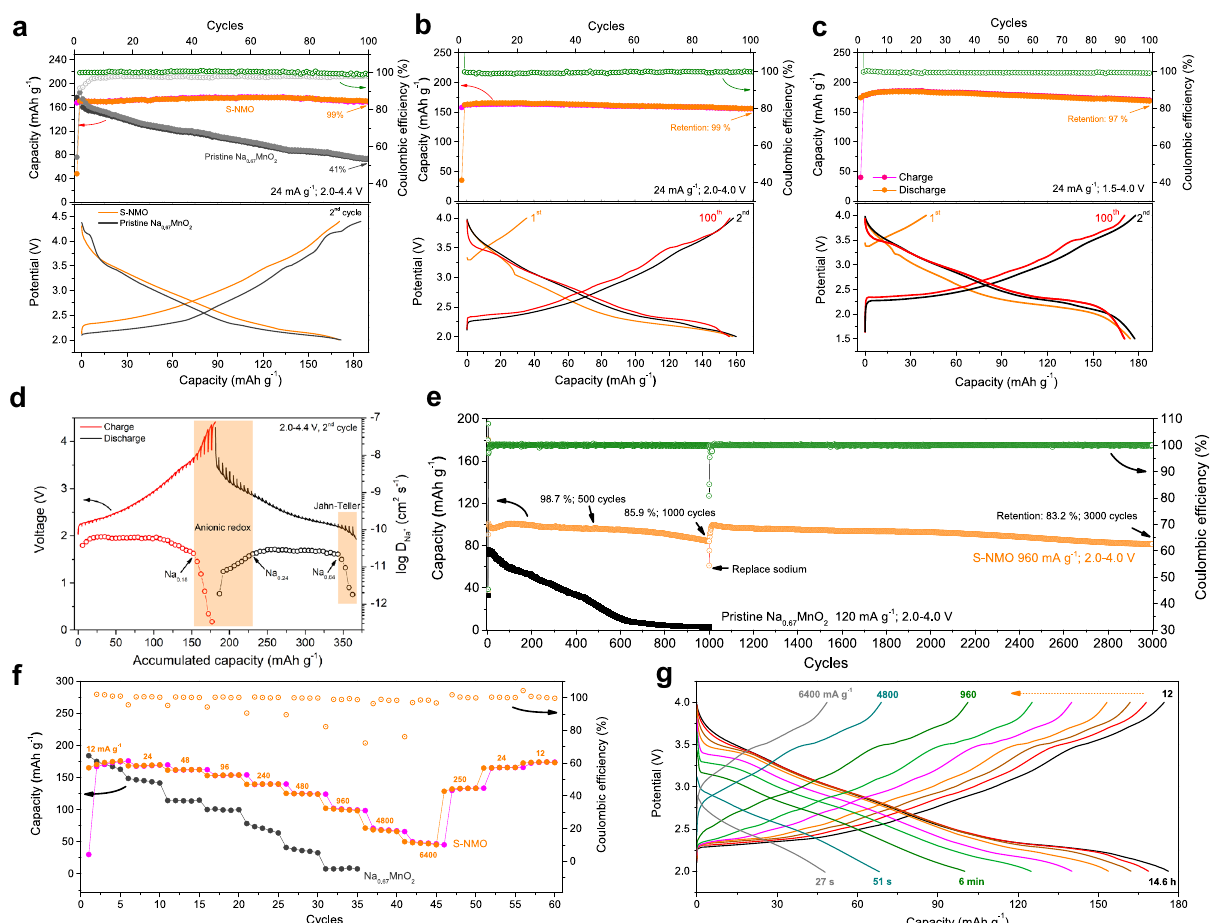
Fig. 5 Electrochemical performances of S-NMO. The cycling performances and charge – discharge curves of S-NMO electrode at 24mA g − 1 within the voltage ranges of a 2.0 – 4.4 V, b 2.0 – 4.0 V, and c 1.5 – 4.0 V. d GITT results of S-NMO electrode. e The comparison of the cycling performance of pristine Na 0.67 MnO 2 and S-NMO electrodes at 120 and 960 mA g − 1 , respectively. f The rate performance of pristine Na 0.67 MnO 2 and S-NMO at the voltage range of 2.0 – 4.0 V. g The charge – discharge pro fi les of S-NMO at different current